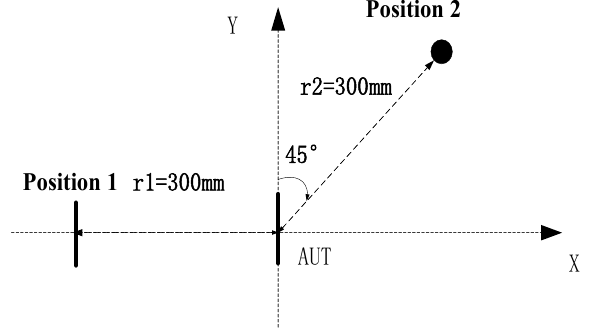
Figure 7. Schematic diagram of the position of the interfering object. turntable, starting from 0 ◦ and ending at 360 ◦ . Samples are taken at an interval of 1 ◦ to test the cross-section radiation field pattern of the azimuth plane of the antenna under test.